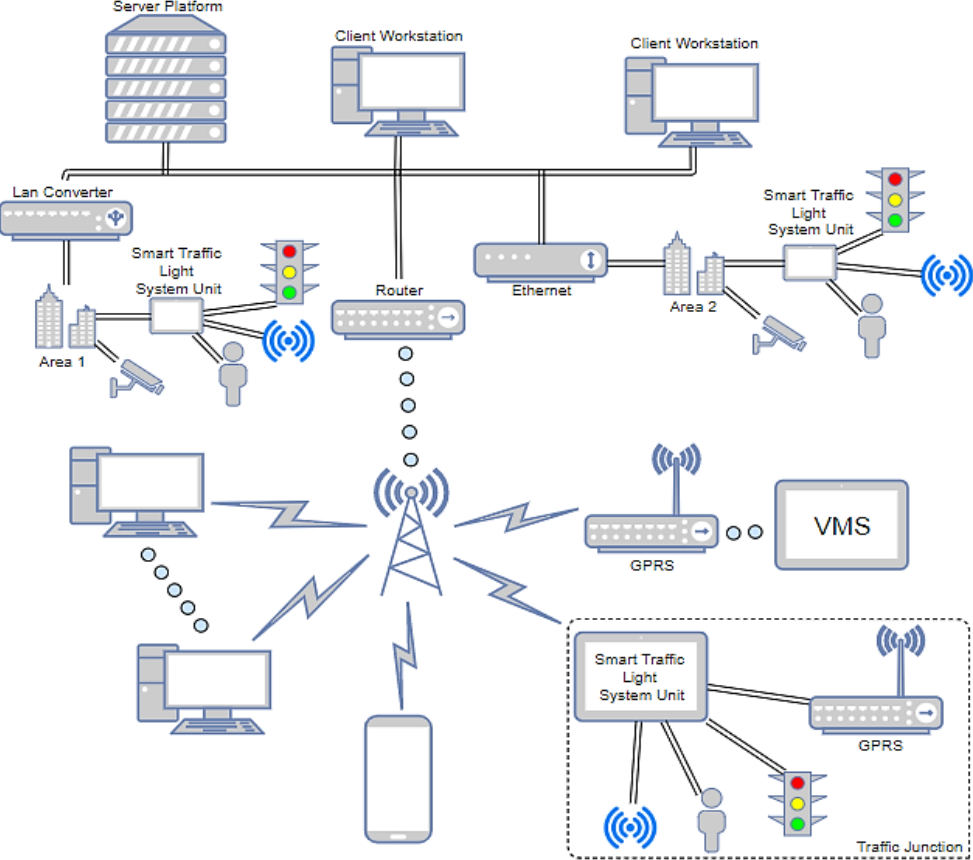
Figure 1. Density-based smart traffic light system